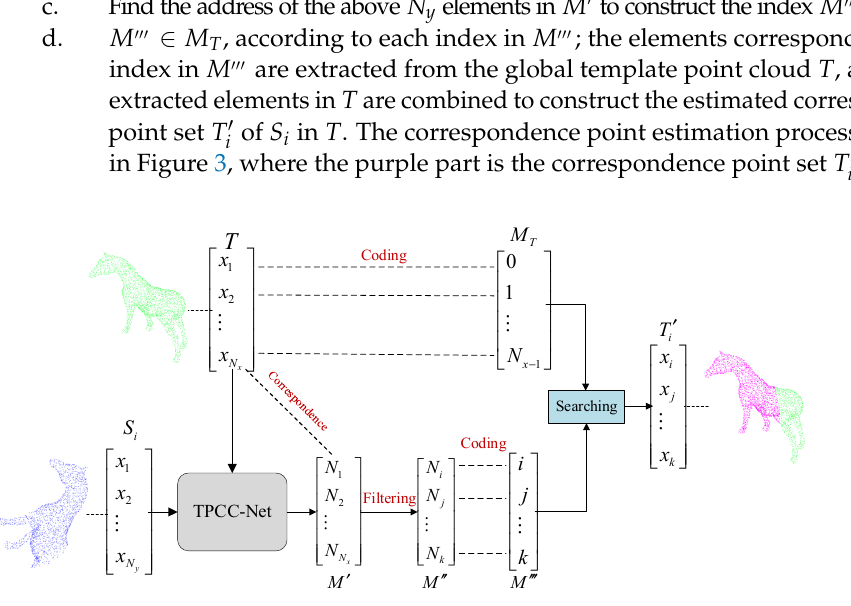
Figure 3. The estimating process of the correspondence points.